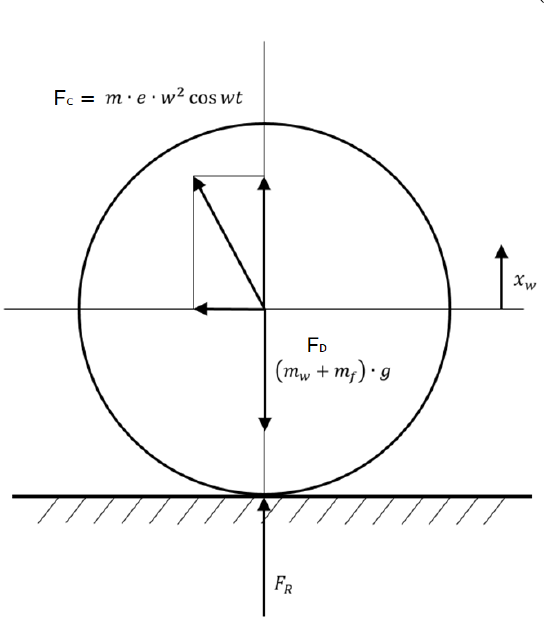
Figure 5. Equilibrium diagram of forces acting on the vibration roller.